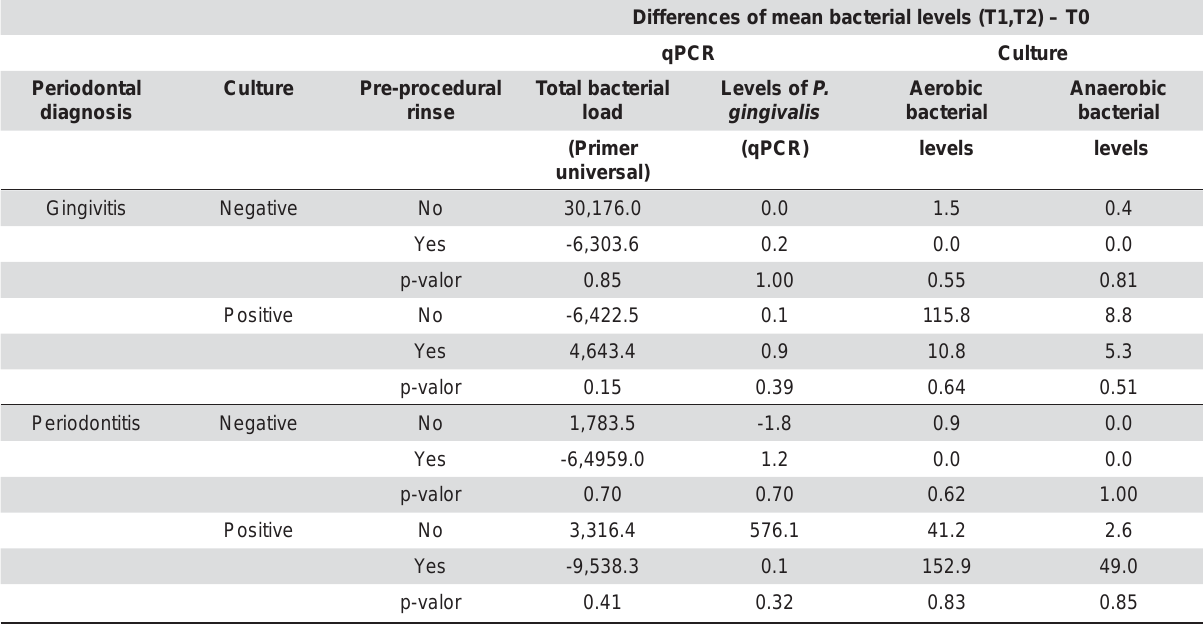
Table 1- Comparative differences of mean bacterial levels (total bacterial load) and P. gingivalis observed at T1 and T2 and mean bacterial levels observed at T0 between individuals who performed the pre-procedural rinse or not according to periodontal